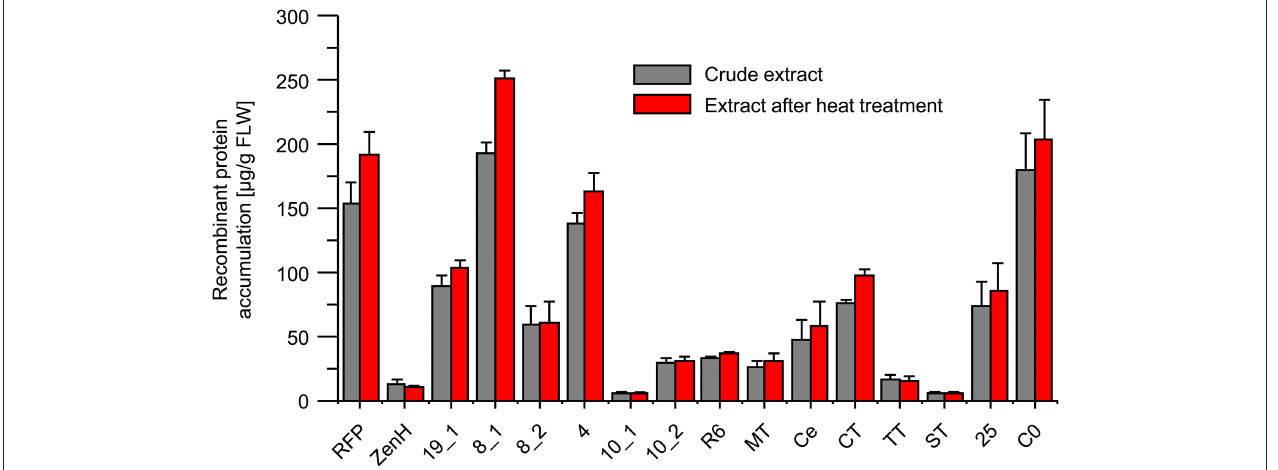
FIGURE 3 | Quantification of RFP-fusion proteins in plant extracts before and after heat treatment by fluorescence detection. The accumulation of RFP-fusion proteins was determined by fluorescence quantification compared to affinity-purified RFP-derived calibration curve. Values are expressed as mean of three biological replicates including standard deviations. Gray columns, crude extract; red columns, extract after heat treatment; lanes 3–16 contain the samples identified in Table 1 . FLW, fresh leaf weight.